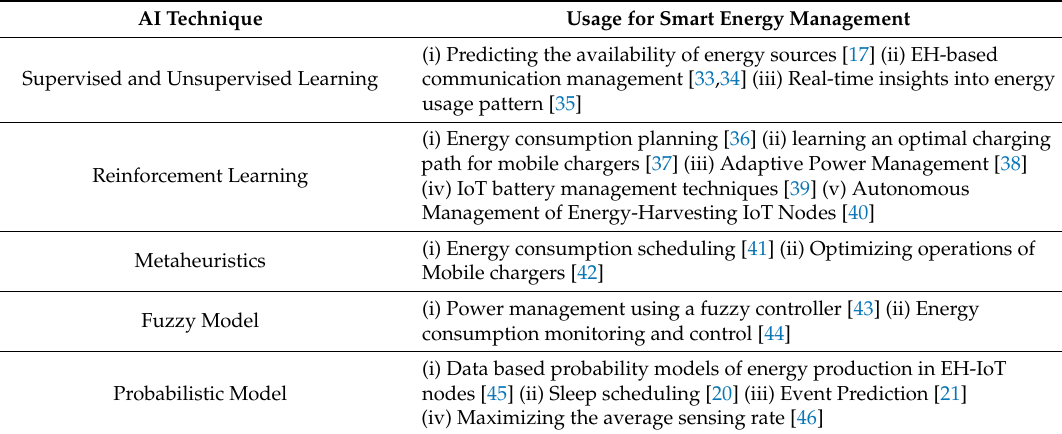
Table 2. Summary of the usage of AI in IoT smart energy management.